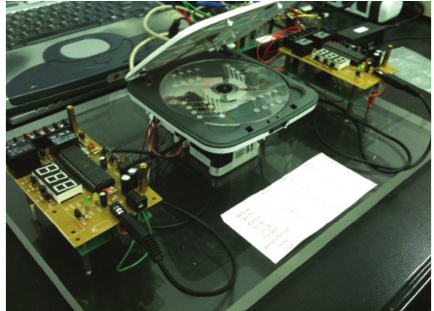
Figure 4: Photograph of the components of the biomedical diag- nostic